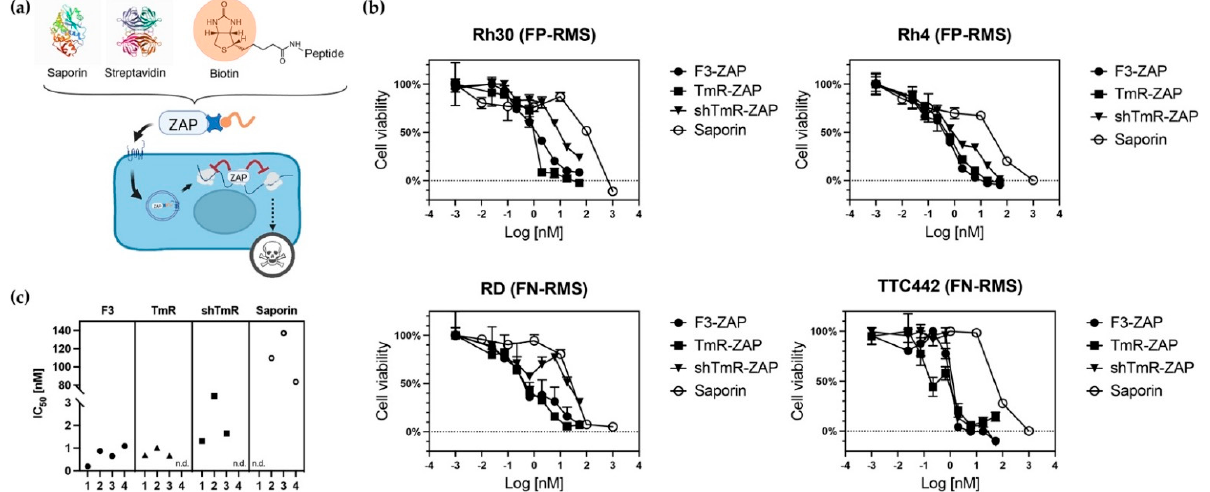
Figure 3. Binding of QD-NTP, QD-F3, QD-TmR, and QD-shTmR to RMS cells and normal fibroblasts and myoblasts. 100 ′ 000 cells were detached with Accutase and incubated in suspension with 20 nM QD-peptides conjugates, or nonconjugated QD-SA as a control, for 1 h at 37 °C, with lung embryonal fibroblasts MRC-5, human myoblasts, and mouse myoblasts C2C12, FP-RMS Rh4, and FN-RMS TTC-442. The fold-binding was calculated as the ratio between the geometric fluorescent mean intensity (FMI) of cells incubated with QD-peptides conjugates and the FMI of non-conjugated QD- SA from three independent experiments. QD-NTP bound efficiently to MRC-5, which are negative for NCAM-1, the target of NCR-peptide; therefore, QD-NTP were not tested on the other cells. n.d.: Not done.